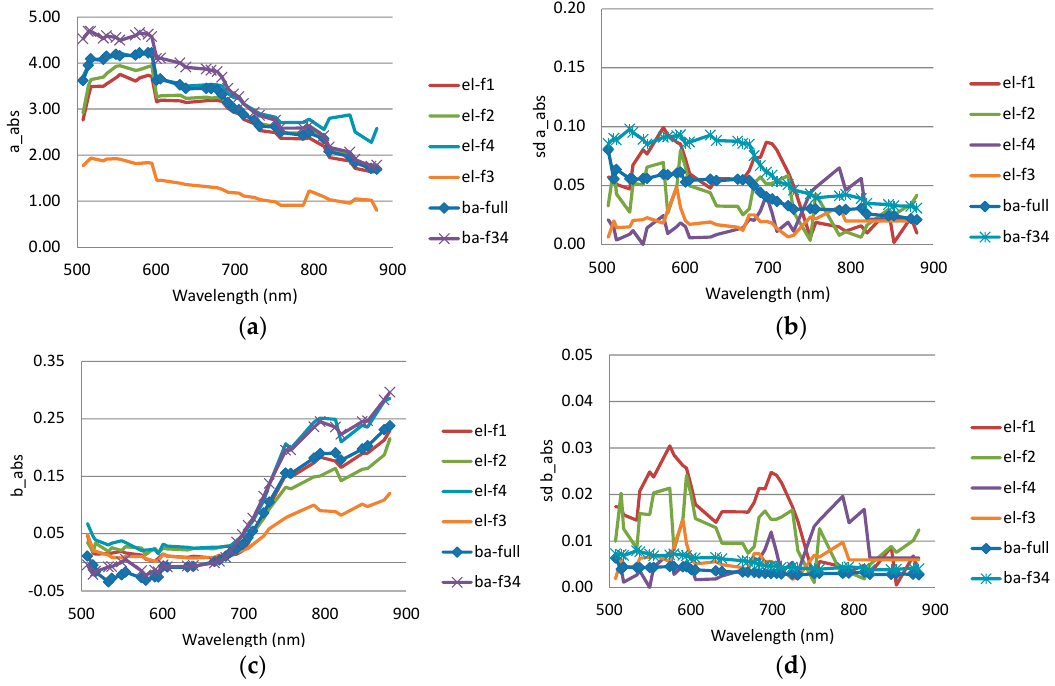
Figure 10. The empirical line parameters and their a posteriori standard deviations for all bands: ( a ) a abs (a_abs) and ( b ) a posteriori standard deviation; ( c ) b abs (b_abs) and ( d ) a posteriori standard deviation. el-f1 to el-f4: parameters by empirical line method using three targets for flights f1, f2, f3 and f4; ba-full: radiometric block adjustment with full dataset; ba-f34: radiometric block adjustment using flight f34.